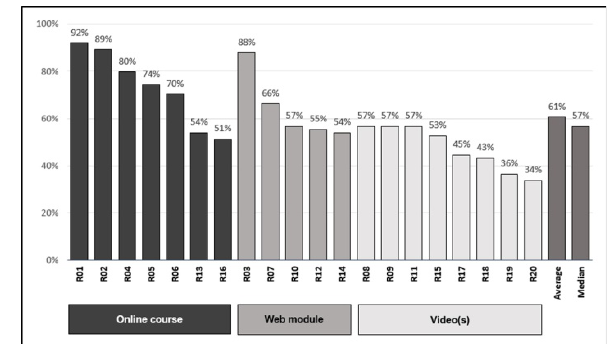
Table 1 Characteristics of the 20 systematic review online resources identified in an environmental scan